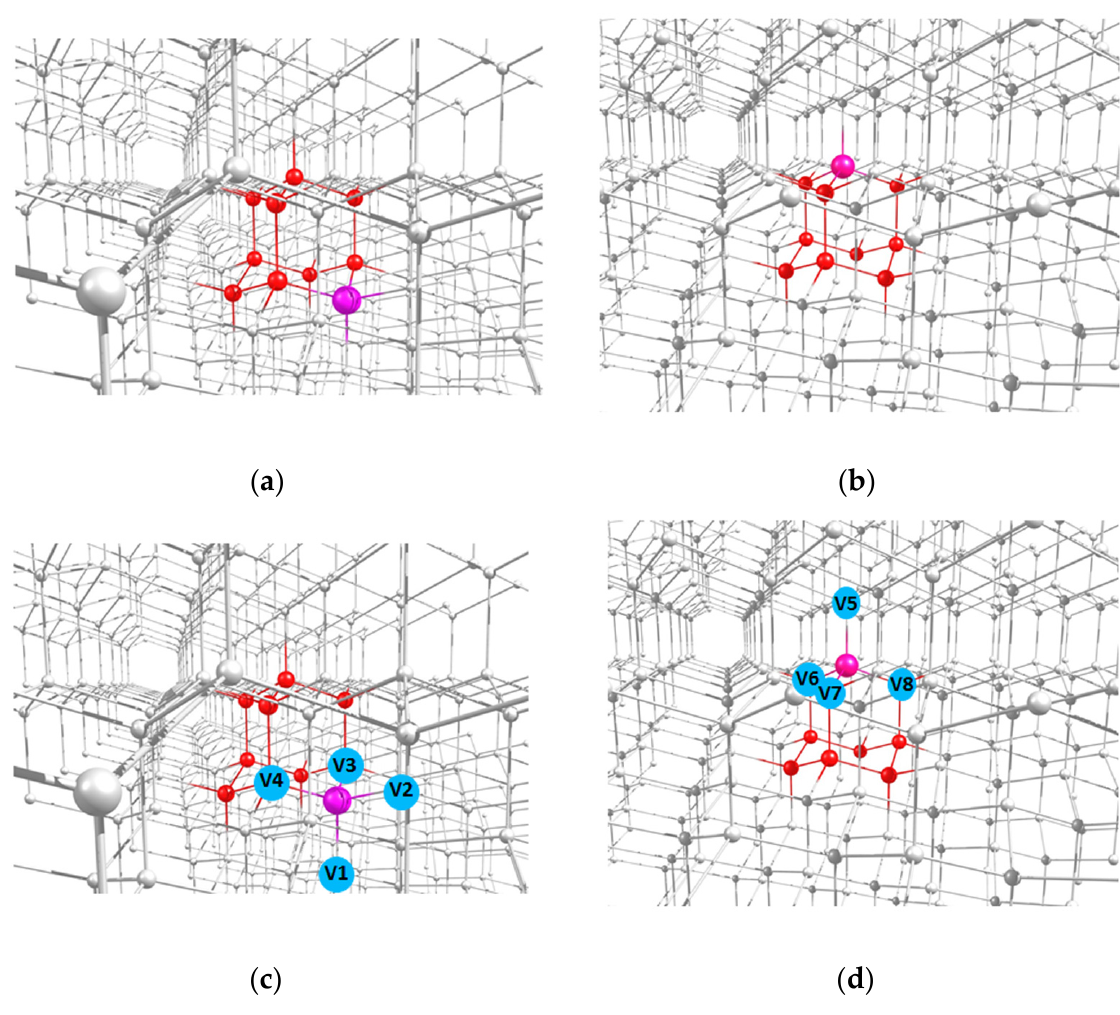
Figure 2. Highlighted locations of the 2-azaadamantane ( a ) and 1-azaadamantane ( b ) seedsin the lattice of diamond nanocrystals grown from them and ( c , d ) possible positions of the vacancies V1–V4 and V5–V8 in the NV1–NV8 centers formed in the nanocrystals obtained from the two above seeds after electron irradiation and annealing. A A +A = and values of the hfi - Table 1. Predicted values of the hfi parameters A ZZ and 2 2 nd ZX ZY induced splitting Δ 0 of the m S = ±1 sublevels for various NV- 13 C systems in diamond grown from isotopic 2-azaadamantane and from 1-azaadamantane at four different positions of the vacancy in the formed NV centers.